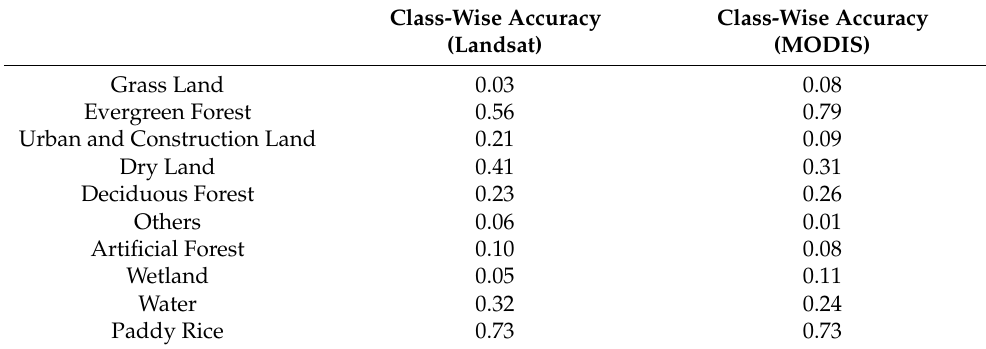
Figure A2. Classification results for ( a ) MODIS and ( b ) Landsat data in the Mun River Basin. Table A2. Class-wise classification accuracy for Landsat and MODIS data in the Mun River Basin.